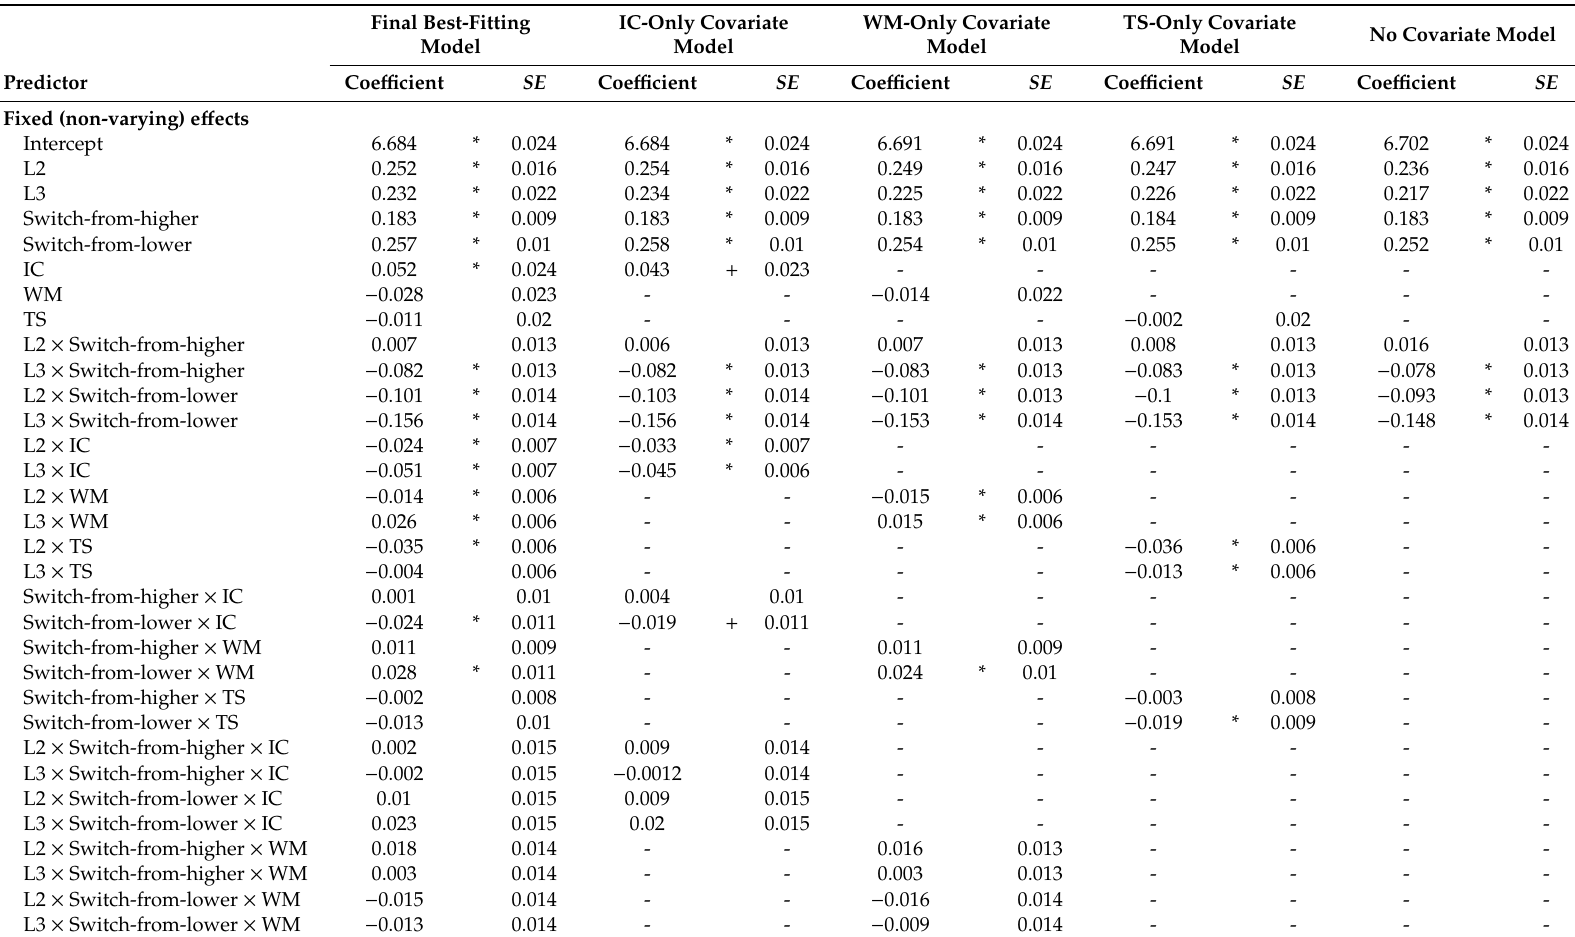
Table A1. Estimated coe ffi cients from the best-fitting mixed e ff ects